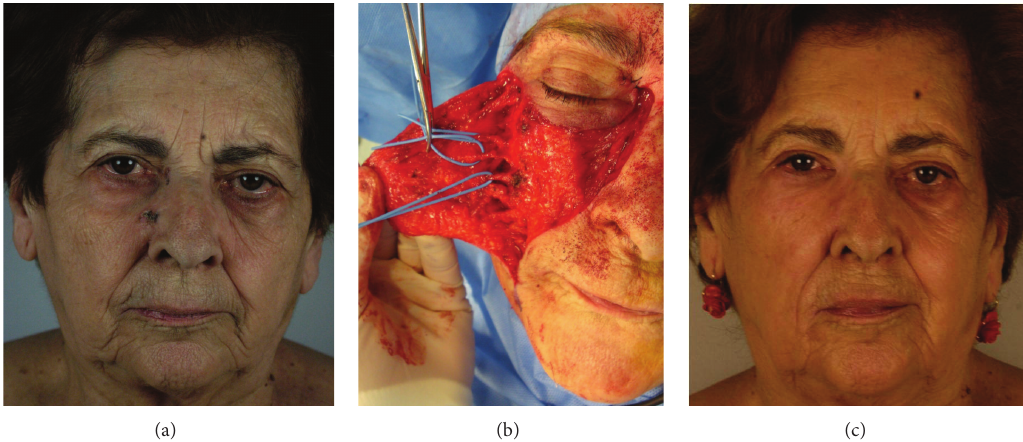
Figure 4: Patient no. 13 showed in Table 1. (a) Multifocal basal cell carcinoma of the right nasal sidewall, medial canthal, and infraorbital unit; (b) (intraoperative view) 3.5 × 3.8 cm defect after tumor resection. Flap elevation in a subcutaneous plane. Identification and preservation of the perforating vessels from the transverse facial branch of the superficial temporal artery. (c) Final result 24 months after